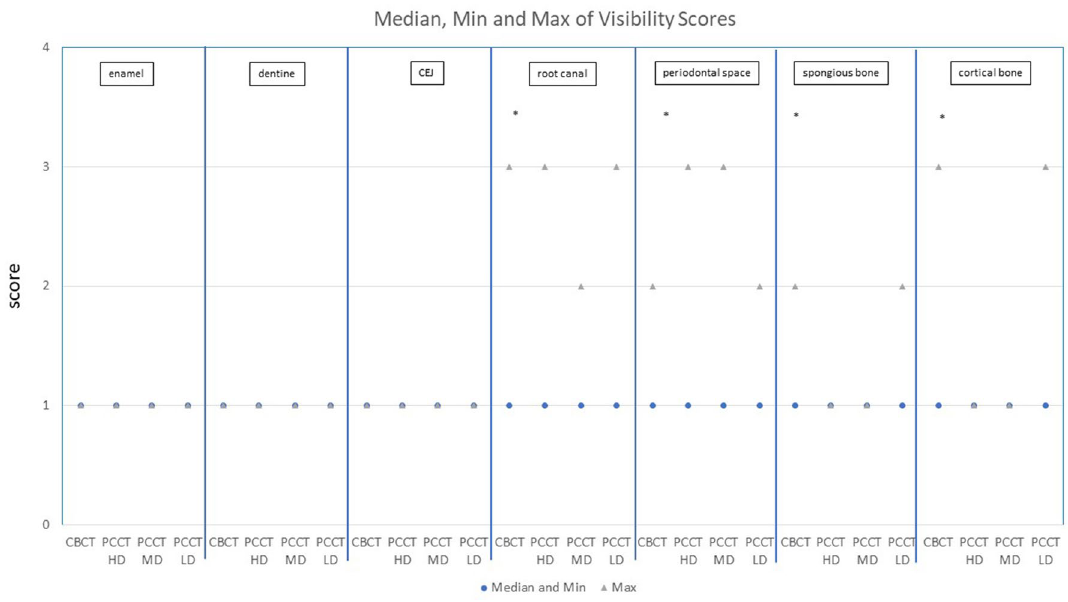
Figure 3. Medians and maximums of visibility scores. The asterisk (*) marks significant differences (p <